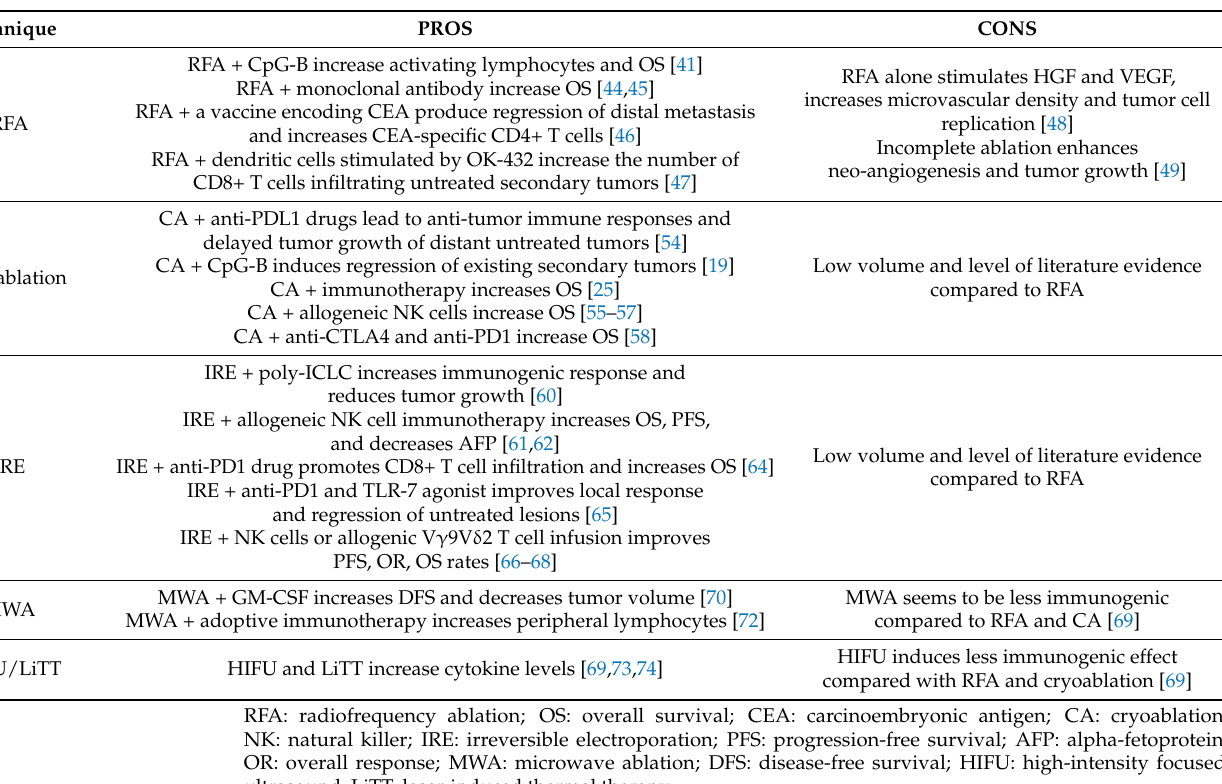
Table 1. Pros and cons of locoregional percutaneous interventional oncology treatments plus immunotherapy.